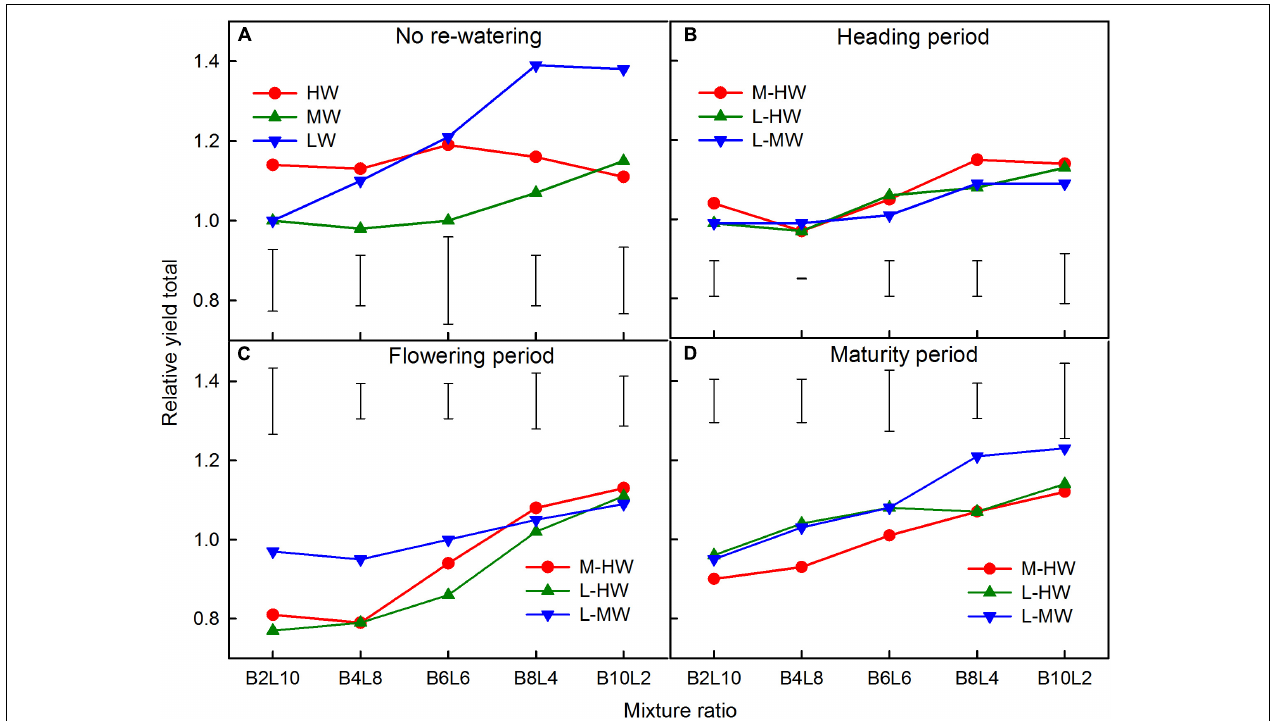
FIGURE 4 | (A–D) The relative yield total (RYT) for the total biomass production of B. ischaemum (B) and L. davurica (L) in the mixtures under the soil watering treatments during different growth periods. B i L j ( i, j = 0, 2, 4, 6, 8, 10, 12; i + j = 12) in abscissa indicates the plant numbers of B. ischaemum to L. davurica in their mixtures; Vertical bars represent LSD 0.05 values. Refer to Figure 1 for the codes of the water